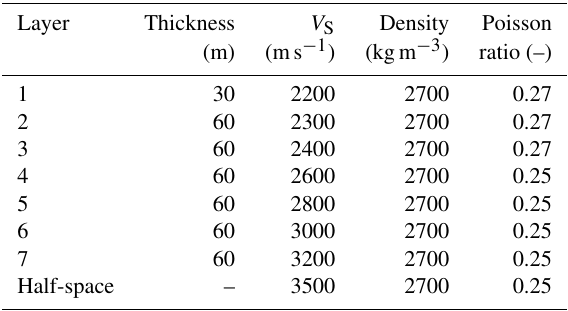
Table 1. Discretization and properties of the initial model of the tomographic